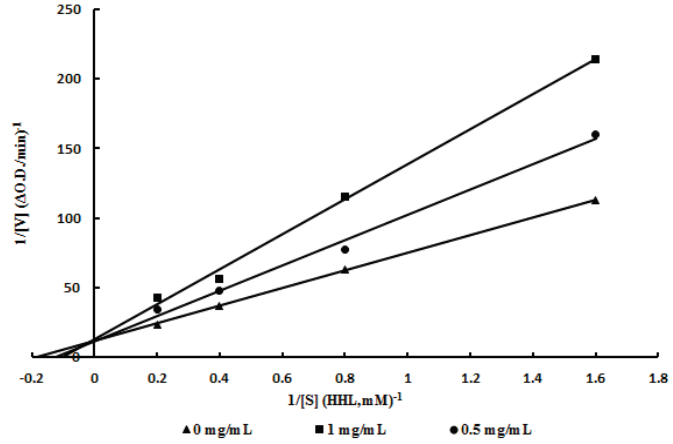
Figure 3. The pattern of LTP to ACE. Lineweaver-Burk plot of ACE inhibitor LTP: ( ▲ ) control, ( ● ) 0.5 mg LTP/mL, and ( ■ ) 1 mg LTP/mL. The intersection of the three lines on the vertical axis signified that the purified ACE inhibitor LTP was a competitive